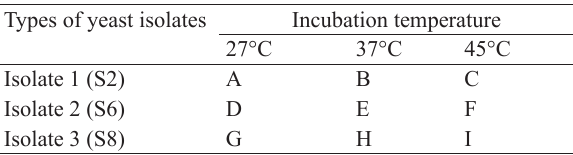
Table 2 Characteristics of indigenous yeast isolates